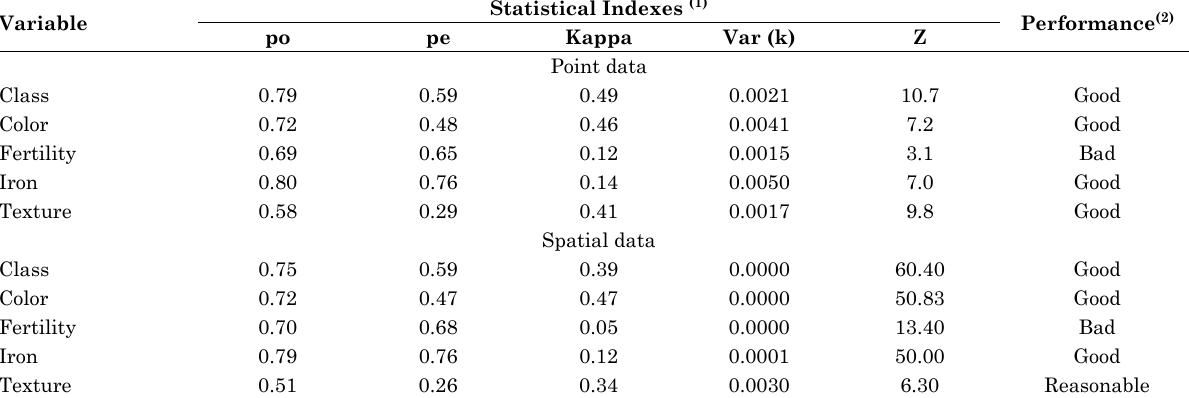
table 4. statistical indexes derived from confusion matrix between point results (bore holes) and spatial results (soil maps) obtained by crossing five variables between the conventional and the digital soil